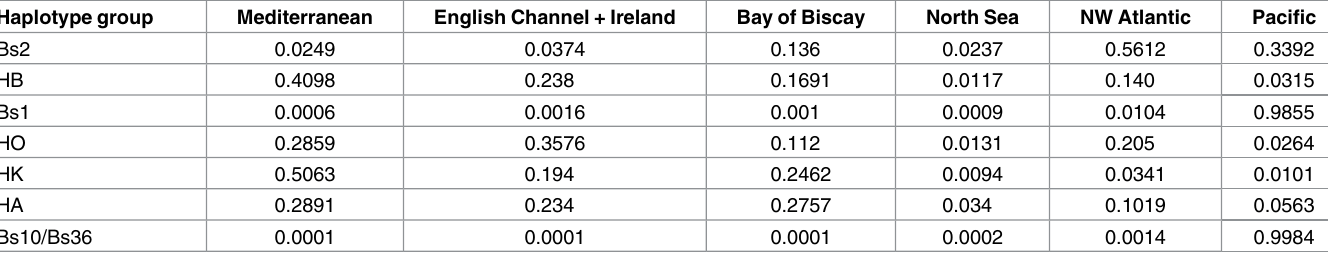
Table 3. Location posterior probabilities for Clade A haplotype groups.